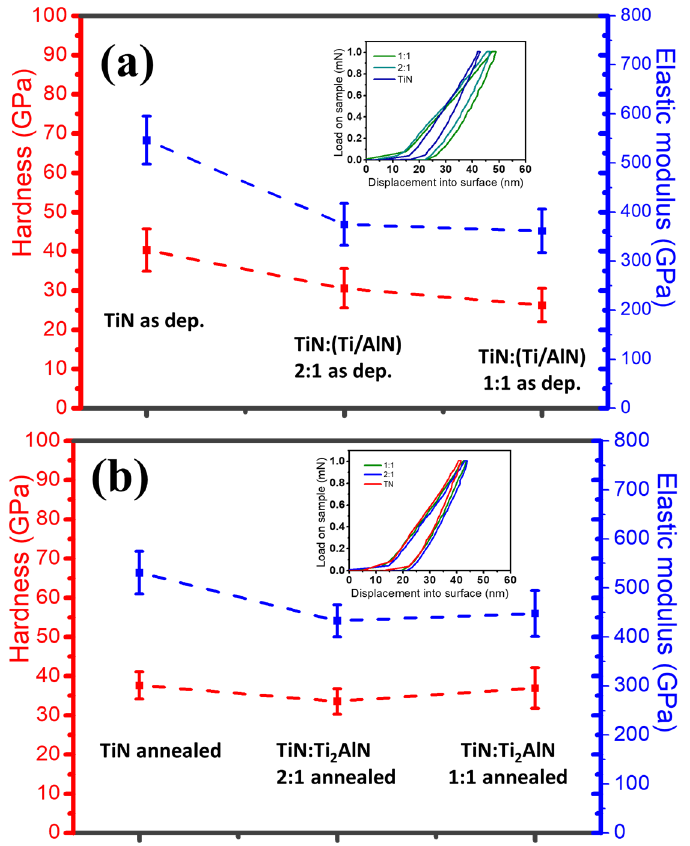
Figure 6. Load–unload curve, elastic modulus, and hardness of the TiN/(Ti/AlN) ( a ) and TiN/Ti 2 AlN ( b ) multilayers.